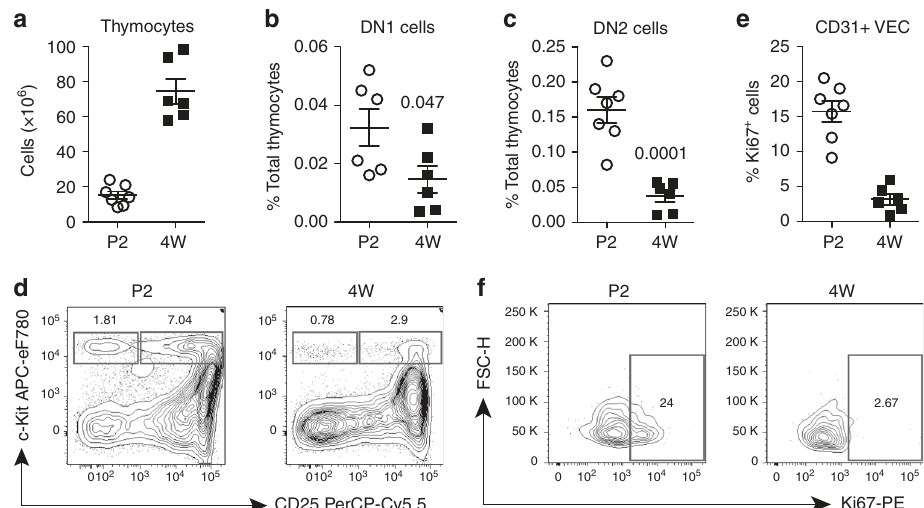
Fig. 5 Thymic VEC proliferation is developmentally coordinated with ETP prevalence. a Total thymic cells from postnatal day 2 (P2) ( N = 7, two experiments) and 4-week-old mice (4 W) ( N = 6, two experiments) (cellularity from 1 lobe). Bars show mean ± s.e.m. b Percentage of phenotypically de fi ned DN1 thymic progenitor cells (Dapi-Lineage-CD4-CD8-CD25-c-Kit + ) from postnatal day 2 (P2) ( N = 7, two experiments) and 4-week-old (4 W) mice ( N = 6, two experiments). Bars show mean ± s.e.m. P -value is shown (Student ’ s t -test). c Percentage of phenotypically de fi ned DN2 thymic progenitor cells (Dapi-Lineage-CD4-CD8-CD25 + c-Kit + ) from postnatal day 2 (P2) ( N = 7, two experiments) and 4 weeks old (4 W) mice ( N = 6, two experiments). Bars show mean ± s.e.m. P -value is shown (Student ’ s t -test). d DN1 and DN2 thymic progenitor cells from postnatal day 2 (P2) and 4-week-old mice (4 W). Plots are representative of two experiments. e Percentage of phenotypically de fi ned Ki67 + VECs (CD45-Ter119-EpCAM-CD31 + ) from postnatal day 2 (P2) and 4-week-old mice (4 W). Bars show mean ± s.e.m. f Ki67 expression in perinatal (P2) and 4-week-old mice (4 W) thymic VECs. Plots